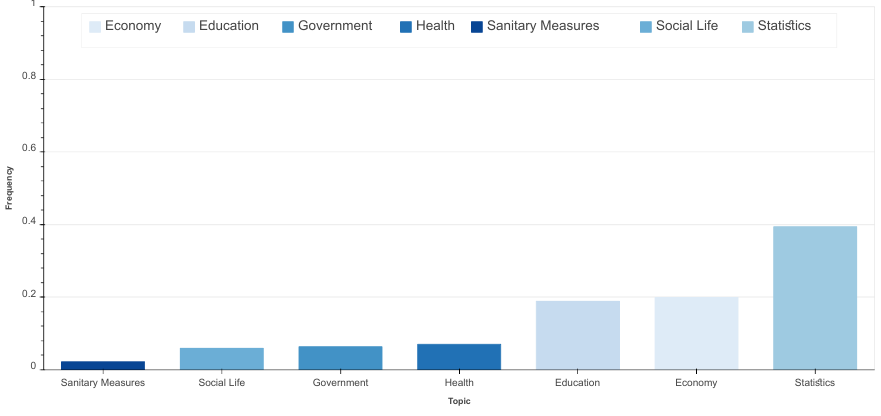
Figure 7. Distribution of topics over